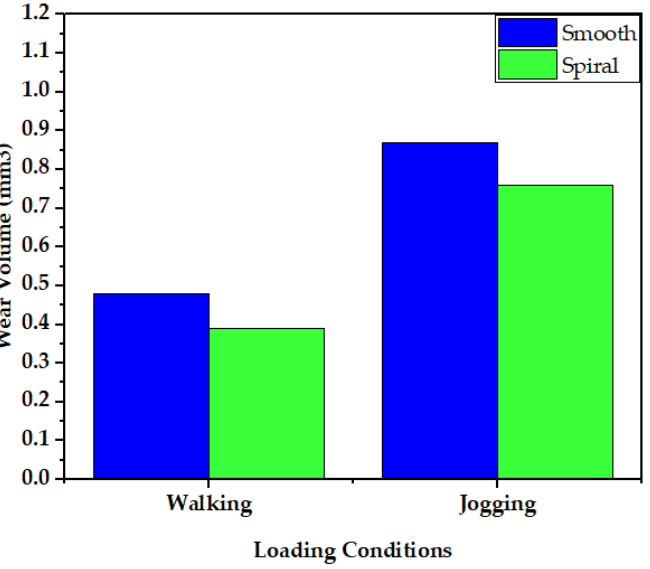
Figure 16. Comparison of wear generation rates in smooth and spiral head-neck tapered joints utilizing the Archard wear estimation model.